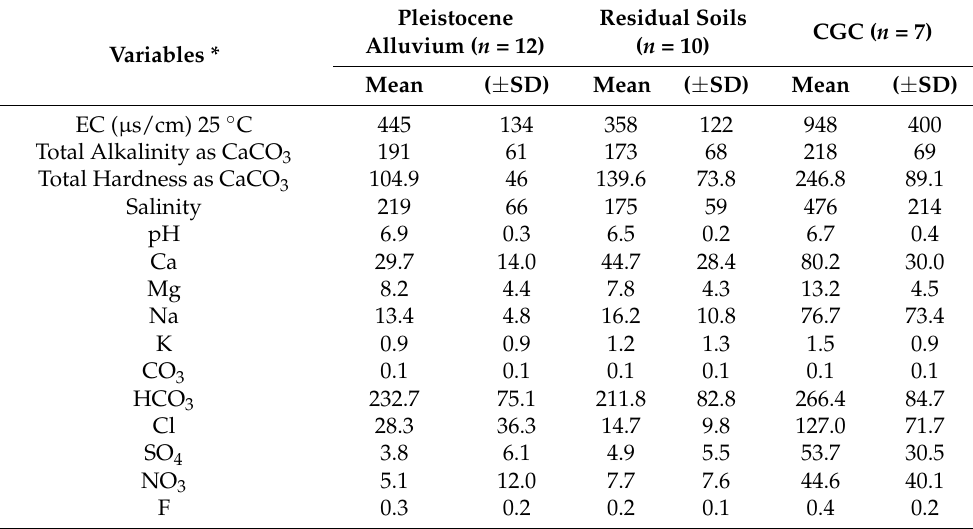
Table 1. Statistical summary of the groundwater chemistry from 29 collected samples.